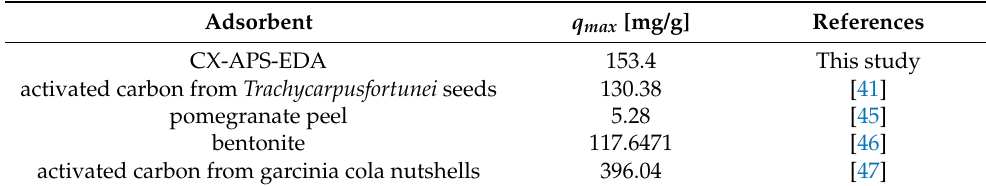
Table 7. Comparison of sorption capacities of the carbon xerogel modified with ethylenediamine to other adsorbents, presented in the literature, towards thymol blue.